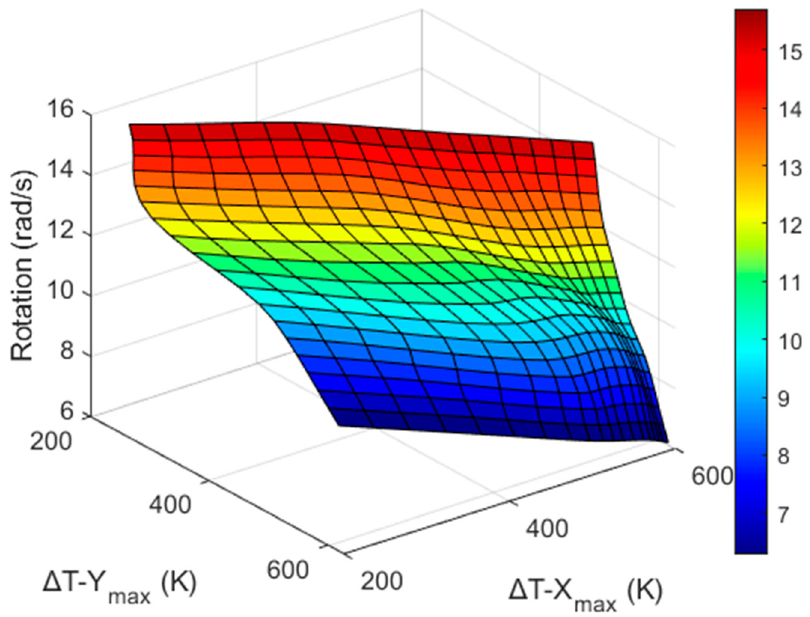
Figure 20. Graph to obtain 𝜔 from Δ T y and Δ T x data measured around heater 3 (isometric drawing).